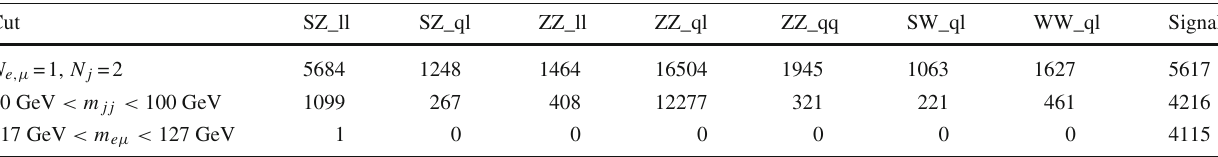
Table 2 The numbers of background events in different categories and signal events surviving the cuts in the analysis of H → e ± μ ∓ at the CEPC. N e (μ, j ) represents the number of electrons (muons, jets) in the final state of an event. See text for details